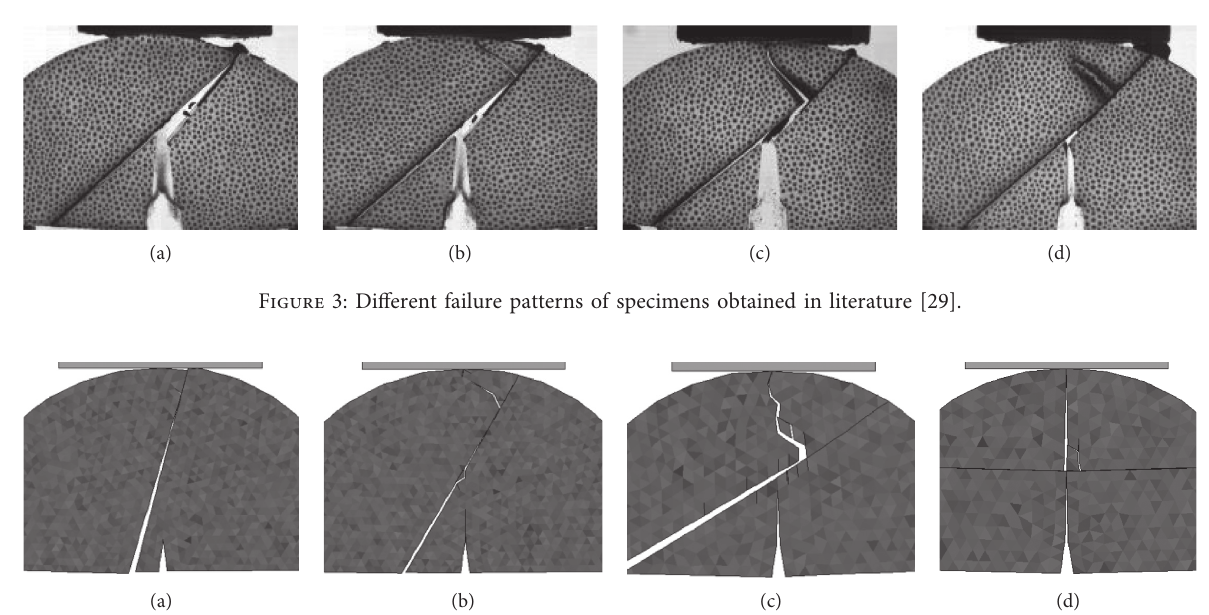
Figure 4: Failure patterns of specimens with different joint orientations under the same loading rate: (a) 15 ° ; (b) 30 ° ; (c) 60 ° ; (d) 90 °